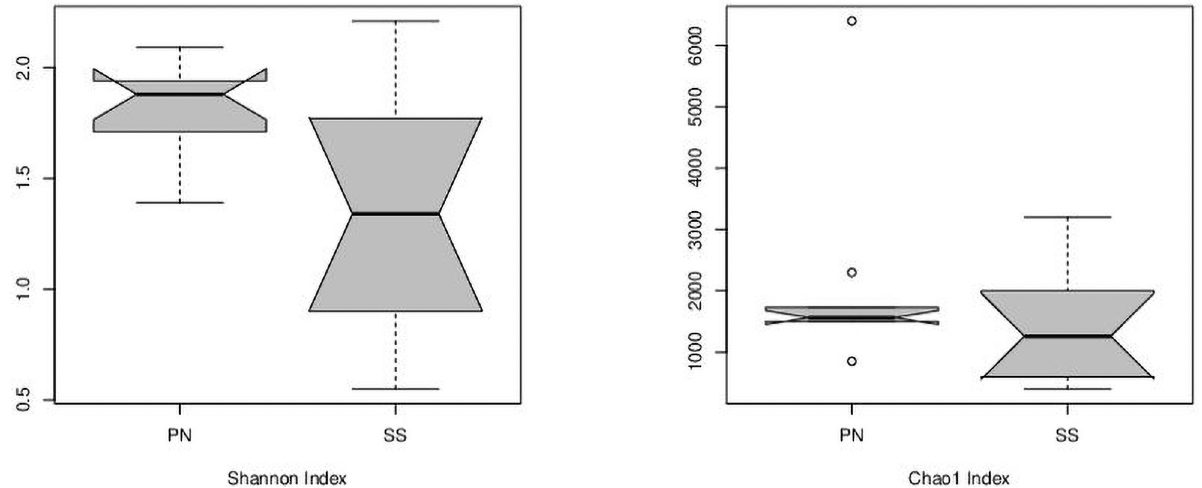
Fig 1. The alpha diversity of the microbial communities in sesame seed (SS; n = 10) and pine nut (PN; n = 10) microbiomes as measured by Shannon and Chao1 indices.